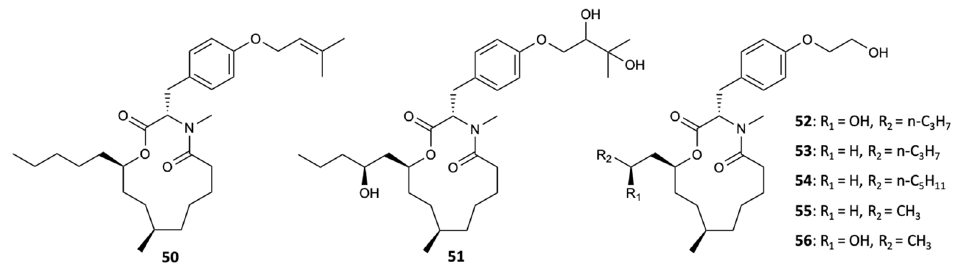
Figure 15. Structures of 13-membered macrolides ( 50 – 56 ).